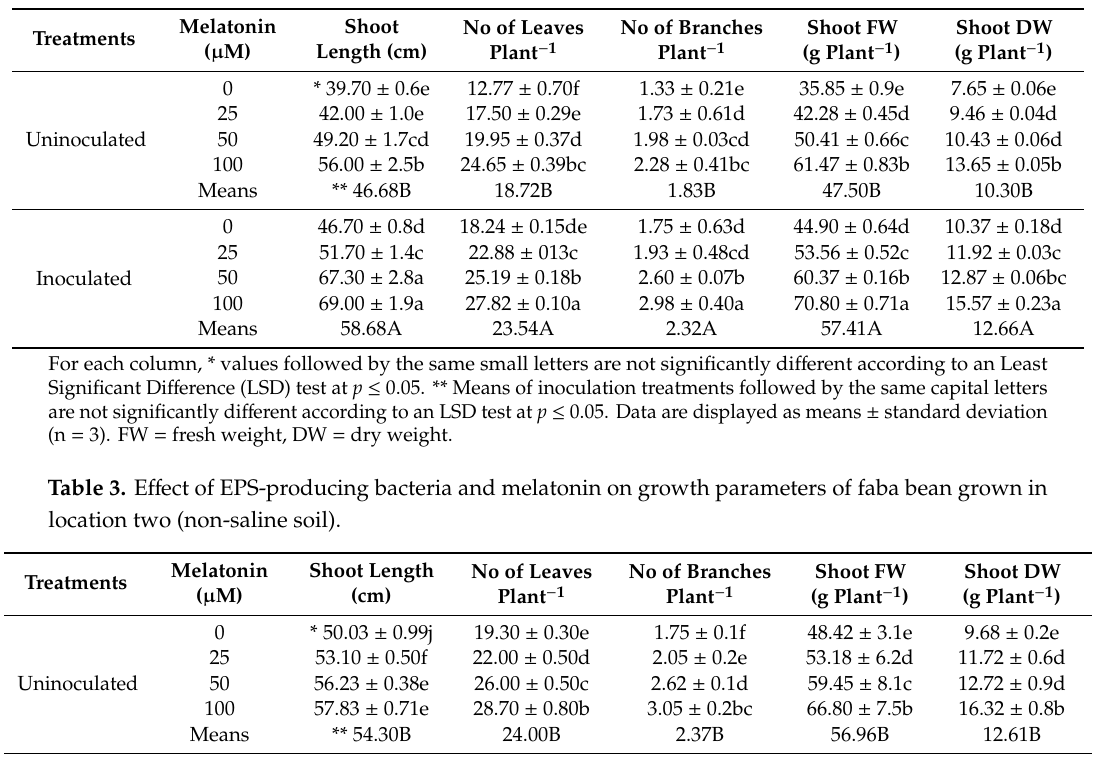
Table 2. E ff ect of exopolysaccharide (EPS)-producing bacteria and melatonin on growth parameters of faba bean grown in location one (saline soil).